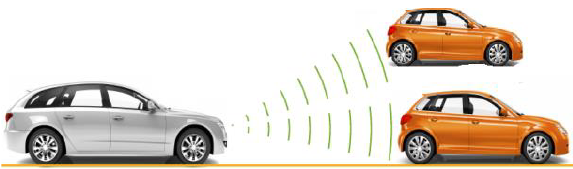
Fig. 2. MIMO radar with 2 transmitters and 4 receivers.